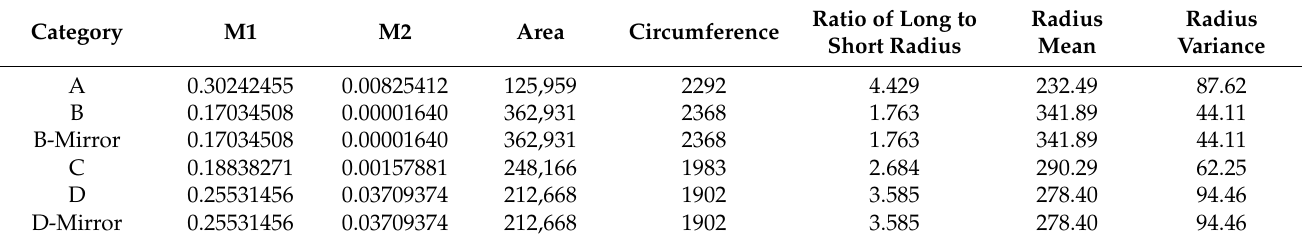
Table 1. Base feature vectors for template shaped